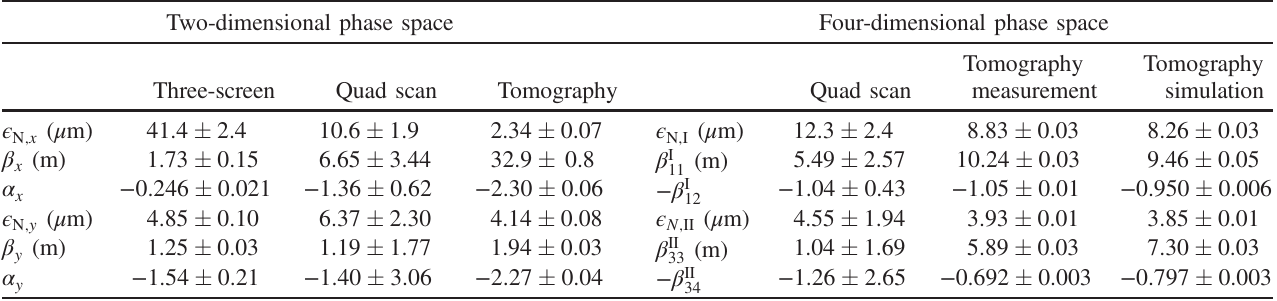
TABLE I. Comparison of values for normalized emittances and Courant – Snyder parameters determined from different analysis techniques. The results from analysis in four-dimensional phase space are for the normal mode emittances and coupled optical functions (see Sec. II). The values for the three-screen analysis technique show the mean and standard deviation of the results of the analysis over the range of points in the quadrupole scan, omitting points that do not return a real value for the emittance. The three-screen analysis method neglects any detailed structure in the beam distribution in phase space, and in this case leads to unreliable results. As explained in Sec. III B, the results from the quadrupole scan analysis show the mean and standard deviation of emittance and optics values obtained from an ensemble of simulated measurements based on the actual measured beam sizes at SCR-03, and the residuals between the predicted beam sizes (from the reconstructed phase space) and the actual observed beam sizes. The uncertainties in the tomography results are based on the standard errors on the parameters of a four-dimensional Gaussian fitted to the reconstructed phase